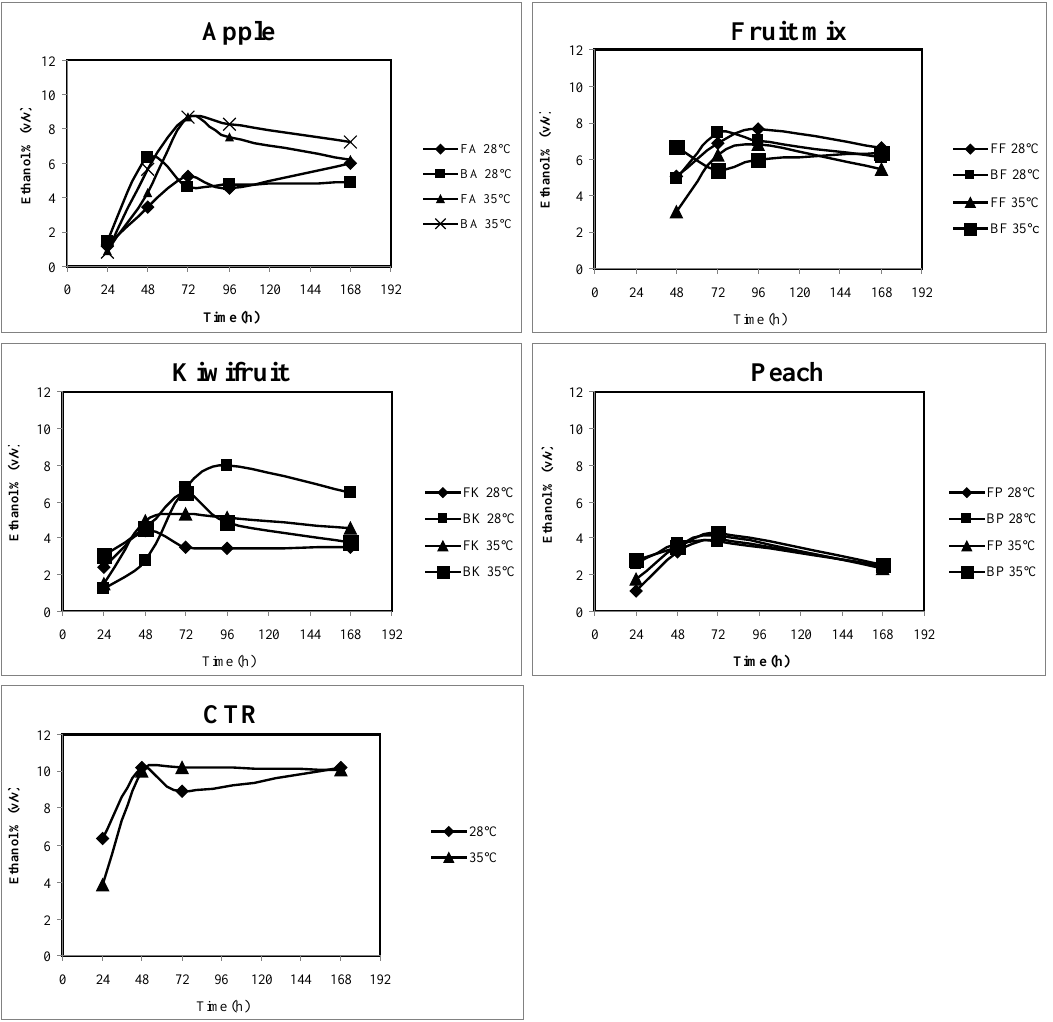
Figure 1. Lab-scale batch fermentation trends. FA: fresh apple; BA: blanched apple; FK: fresh kiwifruit; BK: blanched kiwifruit; FP: fresh peach; BP: blanched peach; FF: fresh fruit mix; BF: blanched fruit mix; CTR: corn threshing residue.